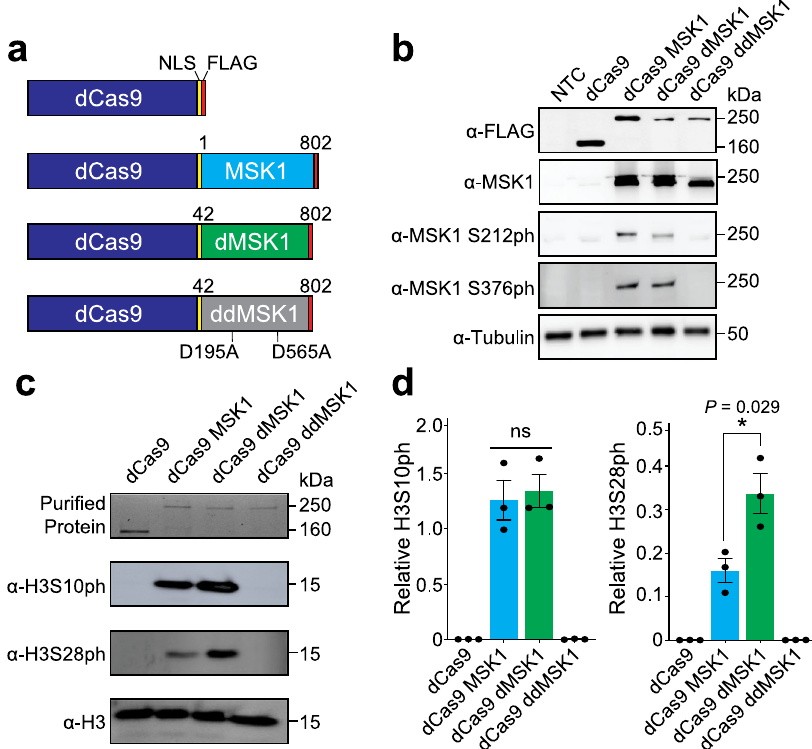
Fig. 1 Development of a CRISPR/Cas9-based histone kinase. a Schematics of dCas9, dCas9 fused to WT MSK1 (dCas9-MSK1), dCas9 fused to a hyperactive truncated MSK1 (dCas9-dMSK1), and dCas9 fused to a catalytically inactivated version of dMSK1 (dCas9-ddMSK1). b dCas9 and dCas9-MSK1 fusion variants were transiently transfected into HEK293T cells and autophosphorylation levels were detected (at serine residues 212 and 376 of MSK1) by Western blot 72 h post-transfection. Data are representative of three independent biological experiments. c Puri fi ed dCas9, dCas9-MSK1, dCas9-dMSK1, and dCas9-ddMSK1 were incubated with human histone octamers in vitro and resulting levels of histone H3 phosphorylation at serine residues 10 and 28 (H3S10ph and H3S28ph, respectively) were measured after incubation for 1 h. d The relative levels of H3S10ph and H3S28ph were quanti fi ed using densitometry from three different in vitro histone kinase assays. Two-sided t -test, * P < 0.05; n = 3 independent experiments in panel ( d ); error bars, s.e.m.; ns, not signi fi cant; kDa, kilodaltons. Source data are available in the Source data fi